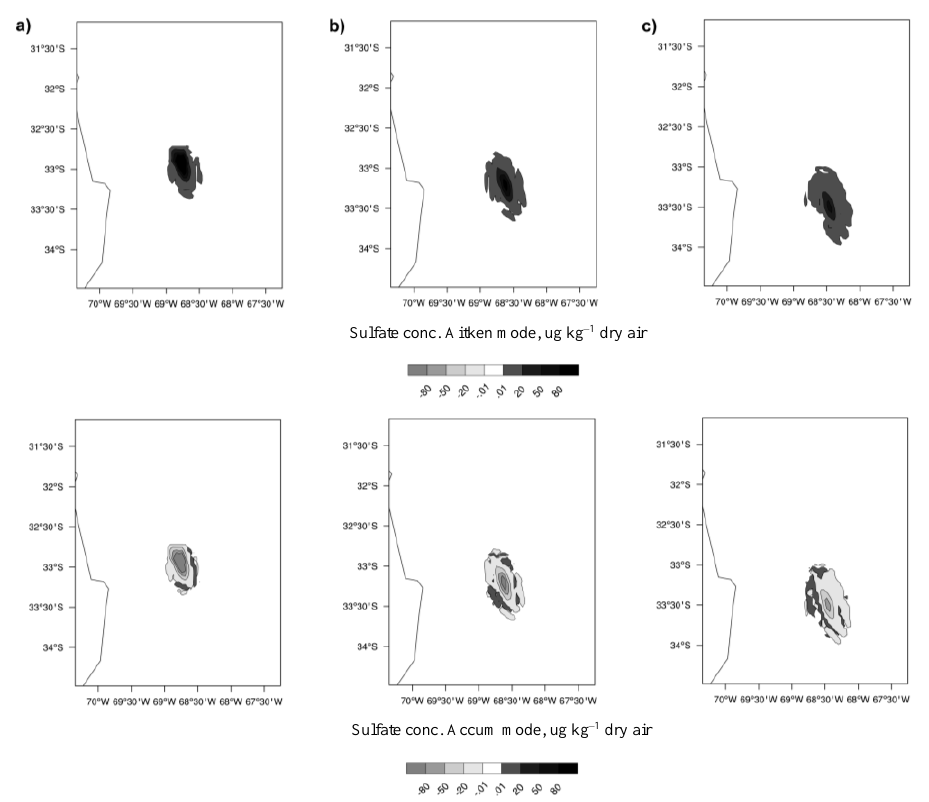
Fig. 11. Aitken-mode (upper panel) and Accumulation-mode (lower panel) SO 42 − concentration anomalies calculated as ID3 − Test_Control at 4 km a.s.l. for different hours of 8 January 2012: a) 10:00 LT; b) 11:00 LT; c) 12:00 LT. The control ability of different configurations of aerosol layers on the target area is analysed below. As of ID3 − ID4, Fig. 12 shows the effects of size distribution of sulfate aerosols. In this regard, according to the MADE/SORGAM module, experiment ID3 considers primary emissions with the Aitken mode (SO4I) which generate concentrations with the Aitken and Accumulation modes, while experiment ID4 (with SO4J primary emission) can only produce aerosols in the Accumulation mode. The upper panel of Fig. 12 indicates the plume corresponding to the total (Aitken mode + Accumulation mode) SO 42 − concentration anomaly at 4 km a.s.l., moving in the S-E direction and moving away from the target area (Great Mendoza). The same figure shows that in the center of the plume, experiment ID4 generates higher aerosol concentrations (positive anomalies) than ID3. The lower panel of Fig. 12 shows that negative anomalies (positive) of the surface shortwave radiation are associated to negative (positive) values of aerosol concentration in upper panel of Fig. 12. As well, these latter anomalies indicate that ID4 configuration with SO 4 J primary emissions produces a higher (lower) surface incoming solar radiation than the ID3 configuration with SO 4 I. Thus, a primary emission in Aitken mode would be more suitable than one in the Accumulation